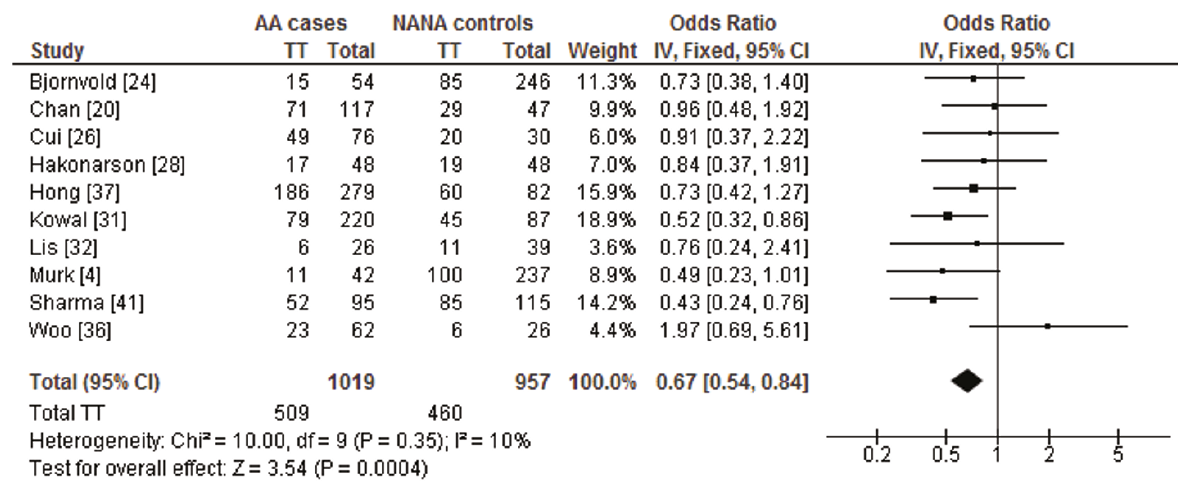
Figure 2 Forest plot of CD14 -260 ( -159 ) TT versus CC genotypes for studies with precisely defined phenotypes . The forest plot displays the meta-analysis results of studies included in the review that used atopic asthma versus non-atopic non-asthma case-control phenotypes, excluding heterogeneous studies identified by sequential analysis [11,27,42]. Meta-analysis was conducted using an inverse variance (IV), fixed effects model. For each study in the forest plot, the area of the black square is proportional to study weight and the horizontal bar represents the 95% confidence interval (CI). Atopic asthma and non-atopic non-asthma are abbreviated as AA and NANA, respectively.